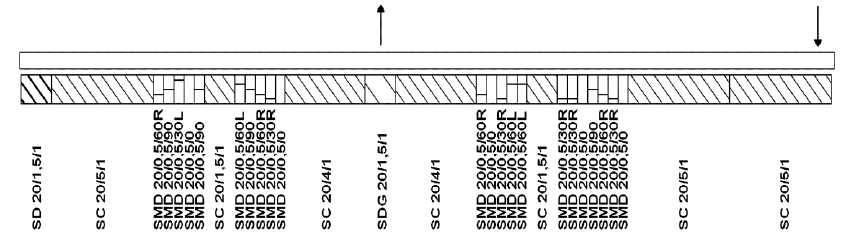
Figure 3. Screw configuration applied during thermo-mechanical treatment of BSG.